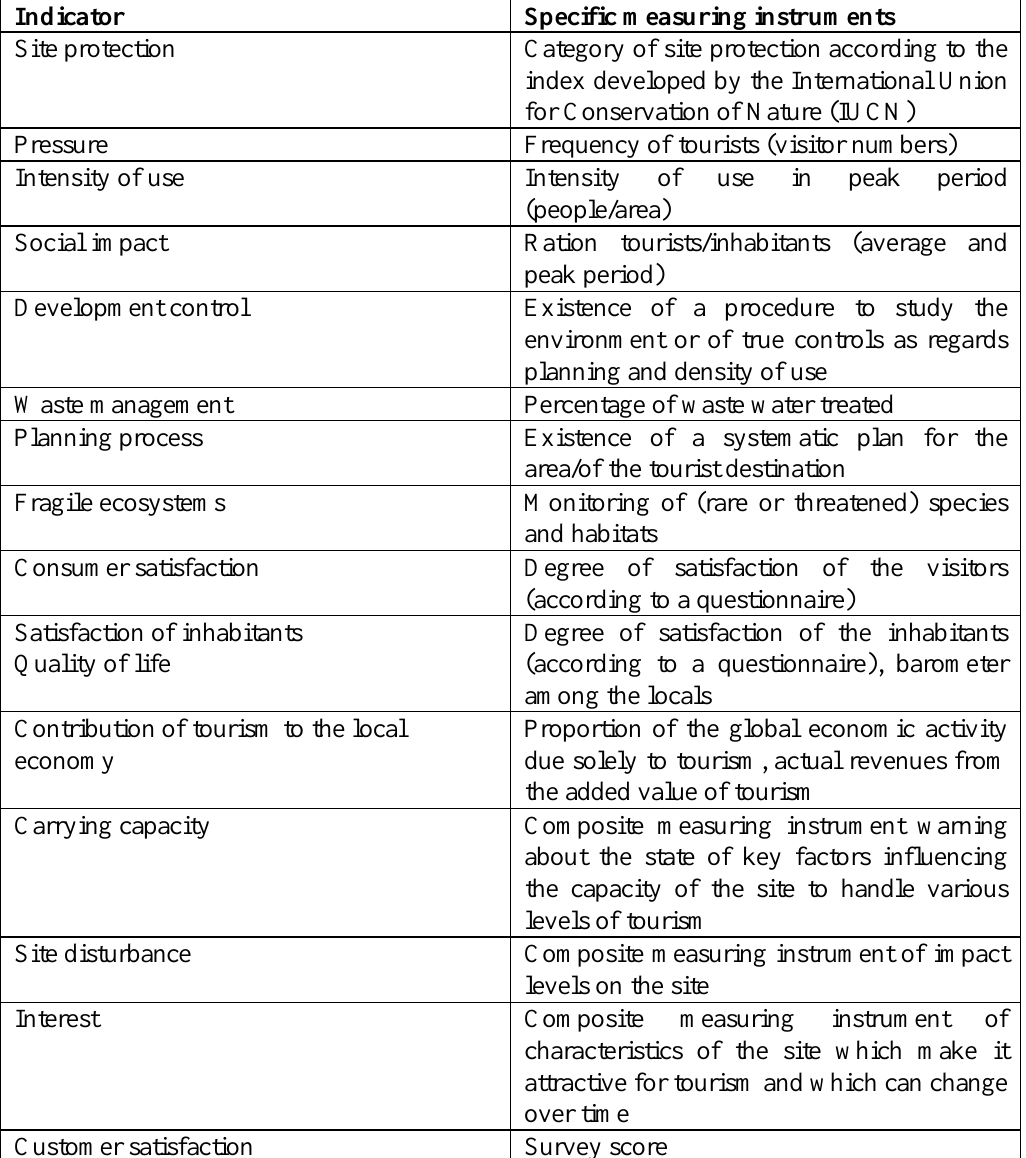
Table 2 : Indicators of Socio-Economic and Environmental Sustainability for Cultural